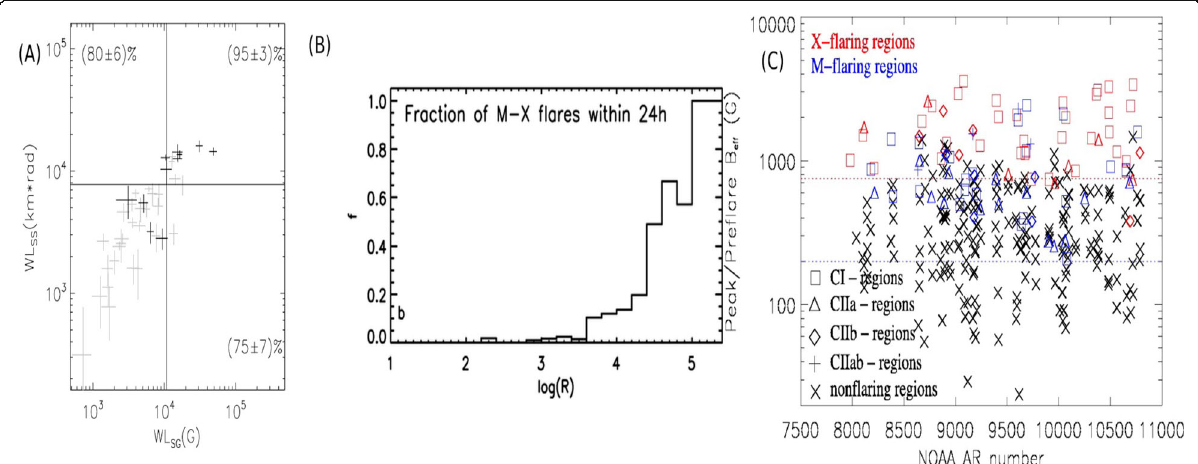
Fig. 37 Examples of magnetic metrics applied to major flares/CMEs. Panel ( a ): the integral of the shear angle along the PILs versus the gradient- weighted integral length of the PILs for 56 bipolar and multipolar ARs. The darker crosses correspond to ARs which gave rise to a CME within the 72 hr search window from the corresponding measurement whereas the lighter crosses correspond to those ARs without a CME with the same search window. From Falconer et al. (2008). Panel ( b ): fraction of ARs with an M- or X-class flare as a function of R, within a 24-hour window from the R recording. 2500 ARs were employed. From Schrijver (2007). Panel ( c ): ARs giving rise to M- or X-class flares (blue and red symbols) and non- flaring ARs (black symbols) versus their peak B eff in a 24-hour search window. 298 ARs were employed. From Georgoulis and Rust